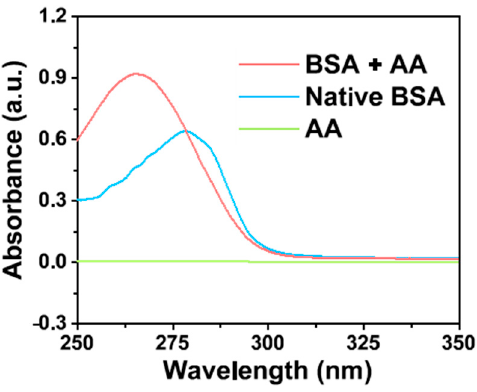
Figure 6. Ultraviolet-visible absorption spectra of BSA in the presence and absence of AA.